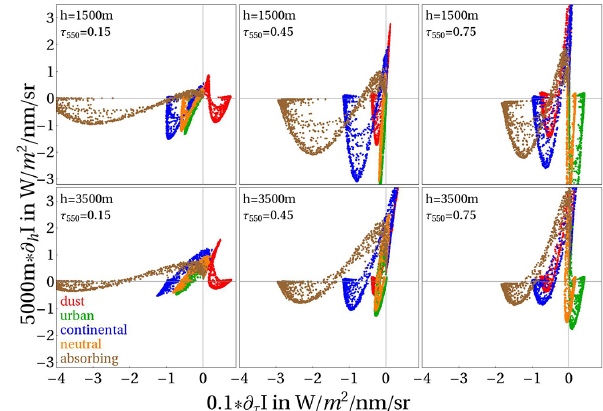
Figure 6. Several scatterplots of the partial derivative spectrum of the fast forward operator with respect to aerosol height and aerosol optical thickness. Both partial derivatives were scaled with a fac- tor with appropriate unit, such that the unit of the resulting quantity is radiance and that both spectra have similar magnitude. Shown in the top left of each panel is the base aerosol optical thickness and aerosol height. Different colors indicate results for the different aerosol types. From the left to right panel, the aerosol height is kept constant and the aerosol optical thickness increases, while from top to bottom panel the aerosol height is changing. The baseline param- eters are solar angle µ S = 10 ◦ , viewing angle µ = 20 ◦ , and relative azimuth angle ϕ = 30 ◦ ; surface reflectance is α = 0 . 2, and surface pressure was set to ρ = 1013